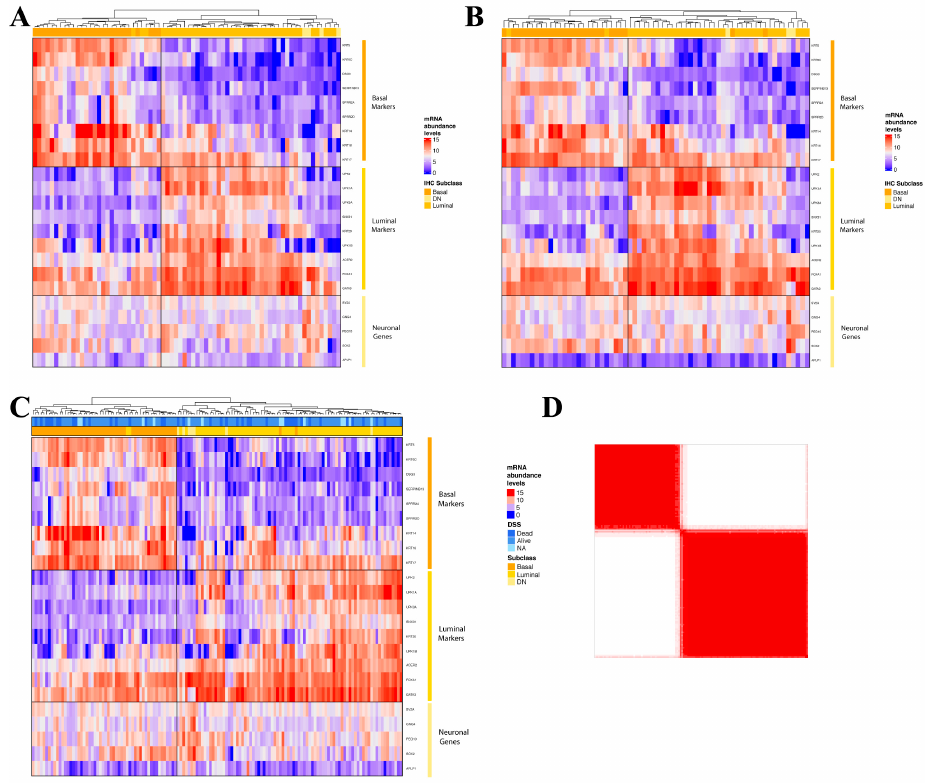
Figure 2. Unsupervised hierarchical clustering (Pearson correlation) of normalized abundance levels of a filtered list of 23 mRNAs derived by NanoString nCounter assay for ( A ) Cohort I; ( B ) Cohort II; and ( C ) total cohort of 138 tumors. Annotation of immunohistochemical subtypes and disease specific survival is indicated for reference. ( D ) Consensus matrix (k = 2) for the total cohort of 138 tumors. Samples represent both rows and columns, and consensus values range from 0 denoted in white (never clustered together) to 1 denoted in red (always clustered together).